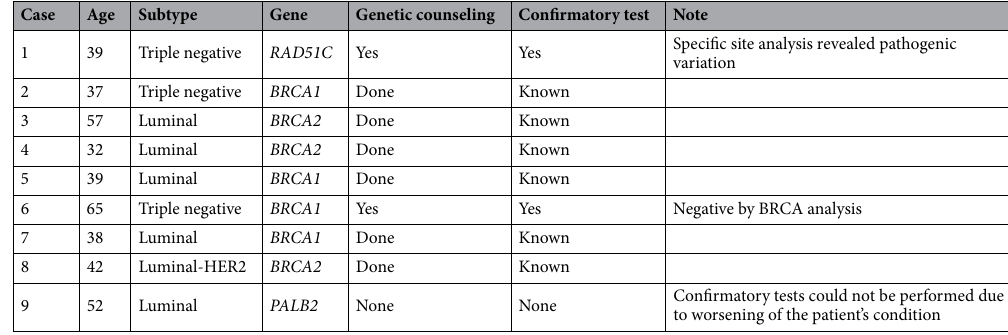
Table 3. Cases involving suspected germline pathological